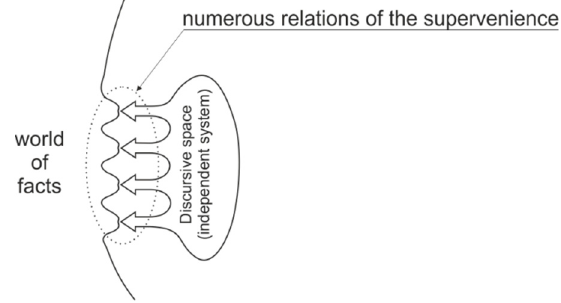
Figure 2. The world of facts and the discursive space.